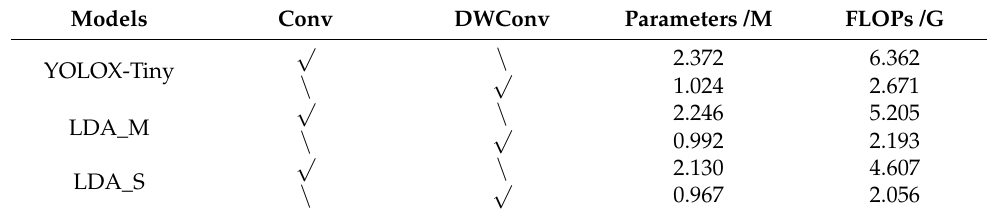
Figure 5. Three backbone network structures. Table 4. Three backbone network